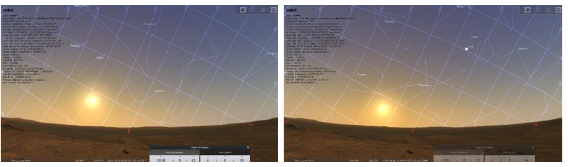
Figure 11. The simplified version (smooth surfaces model) created in